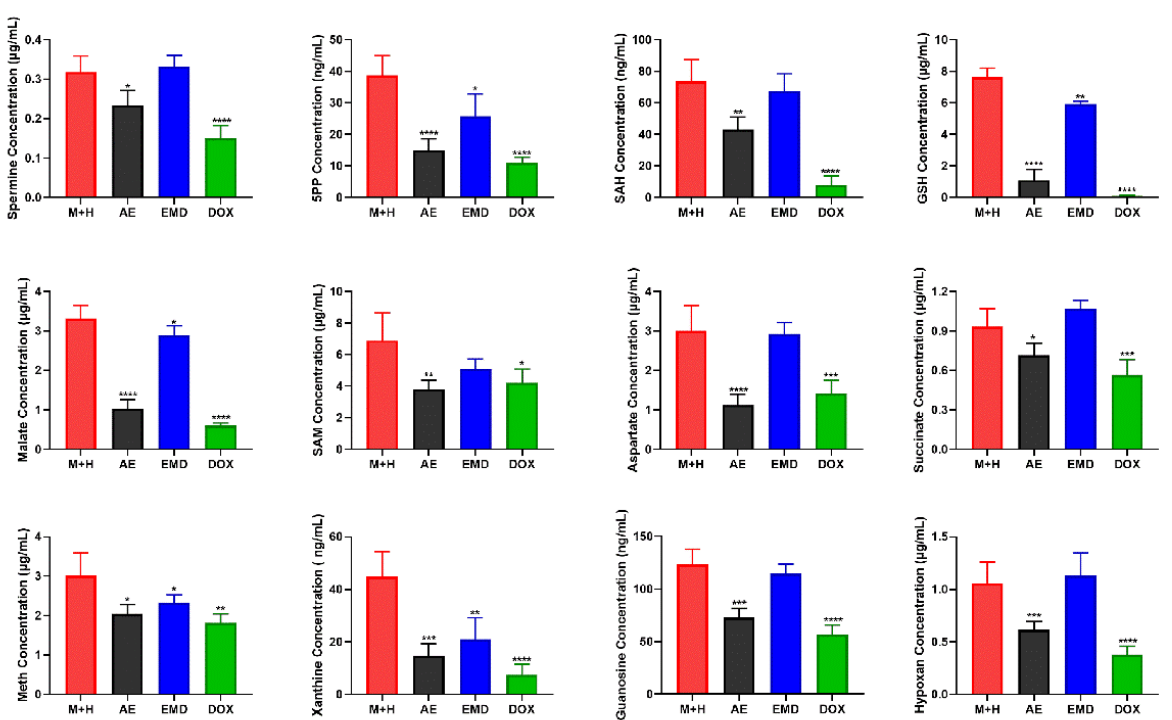
Figure 7. Quantitative analysis of biomarkers. The data are expressed as the mean ± SD ( n = 6). * p < 0.05, ** p < 0.01, *** p < 0.001, **** p < 0.0001 compared with control group.